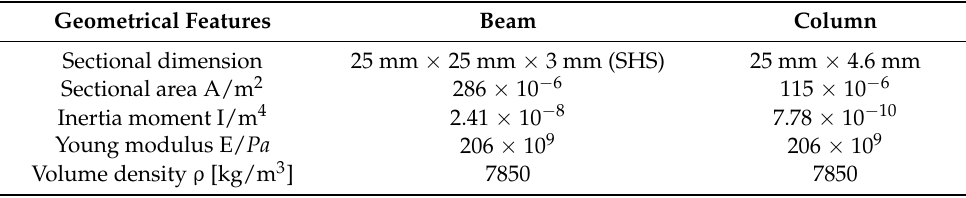
Figure 10. Testing of a seven − story steel frame structure.